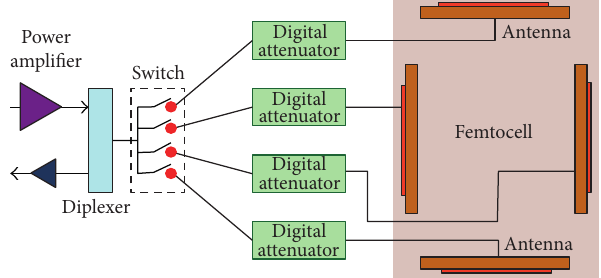
Figure 1: Multielement antenna configuration in femtocell (microstrip